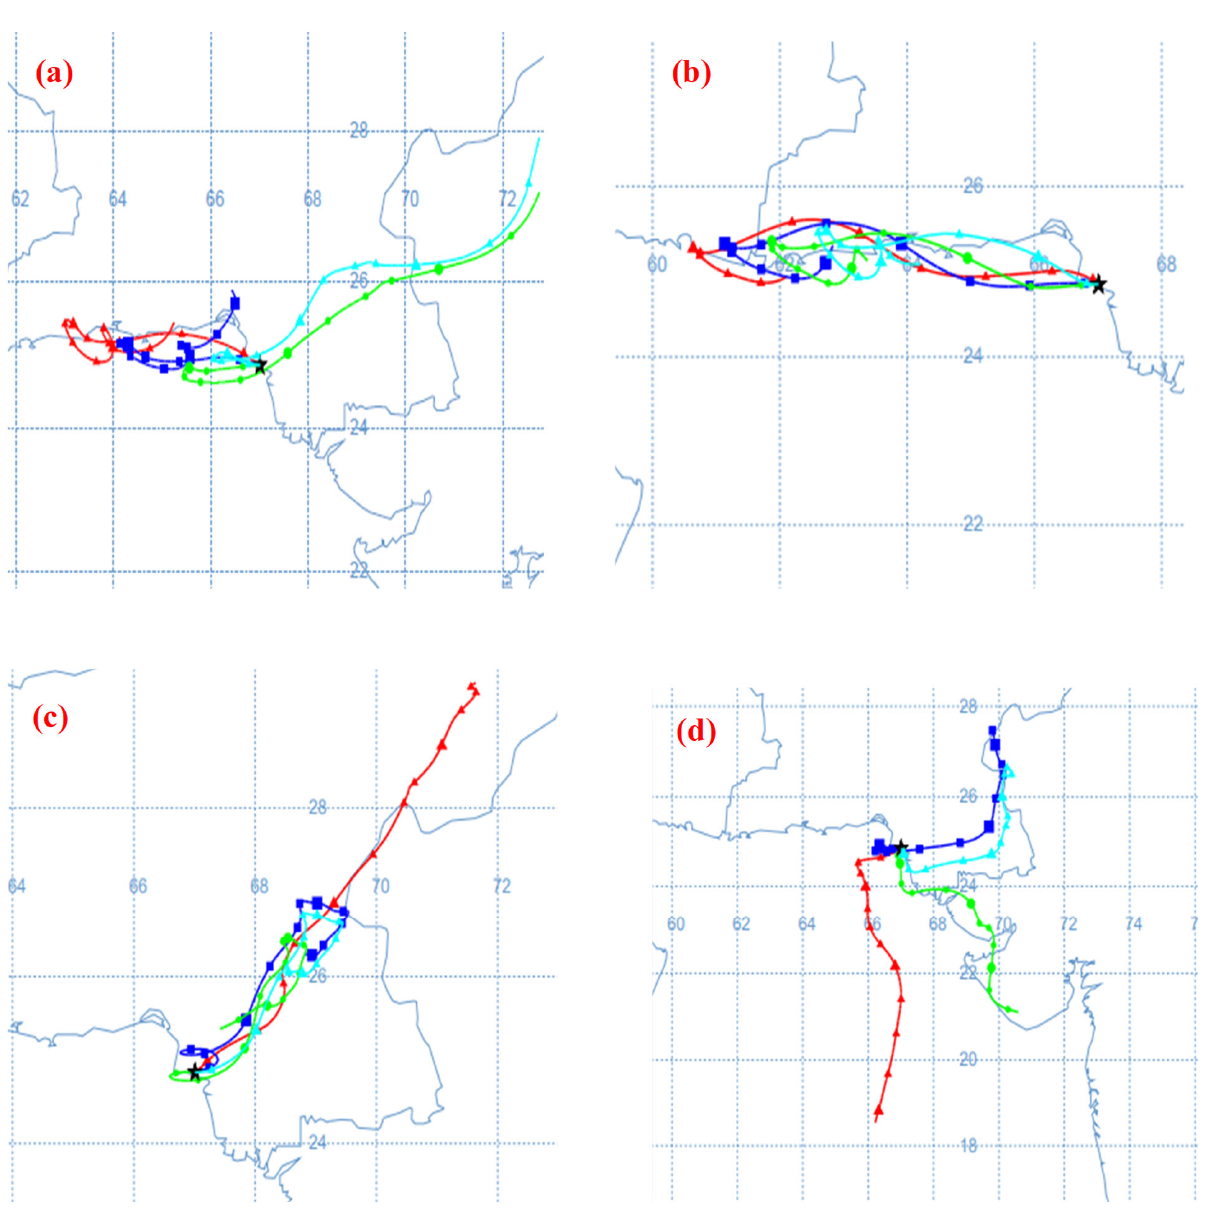
Figure 4. Plots of 72-hr backward-in-time trajectories depicting wind direction and its effect on the daily transport and dilution of air pollutants during the study period for the maximum and minimum concentrations at the Port of Albany. Note: Maximum concentrations: ( a ) 0.374 and 0.465 µ m on 8 November 2018; ( b ) BC ng/m 3 and 0.3 µ m on 9 November 2018; ( c ) PM 1 , PM 2.5 , PM 7 , PM 10 , and TSP µ g/m 3 on 15 November 2018; ( d ) Minimum concentrations for 0.3, 0.374, 0.465 µ m, PM, and BC on 6 November 2018.